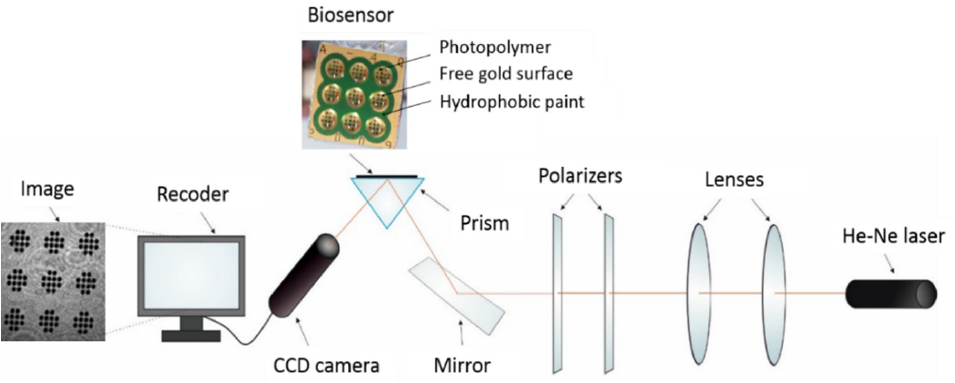
Figure A1. Schematic diagram of the SPRi apparatus and chip architecture.